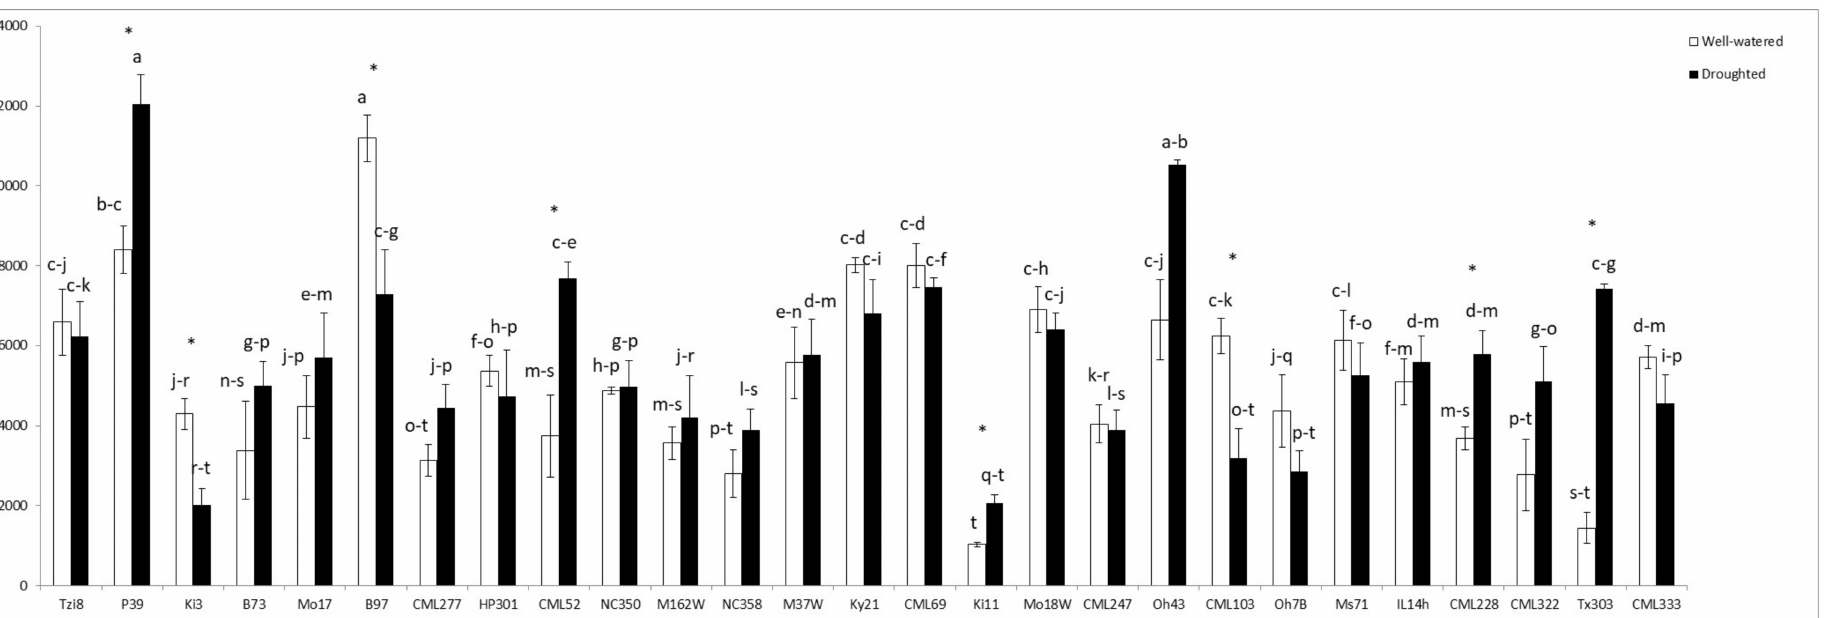
Figure 4. Hydrostatic root hydraulic conductivity (Lh) in the whole maize NAM population cultivated under well-watered conditions or subjected to drought stress. Data represents the means of 6 values ± S.E. Different letters indicate significant differences between treatments ( p < 0.05) based on Duncan’s test. Asterisks indicate significant differences between well-watered and droughted treatments within each maize line, according to Student’s t